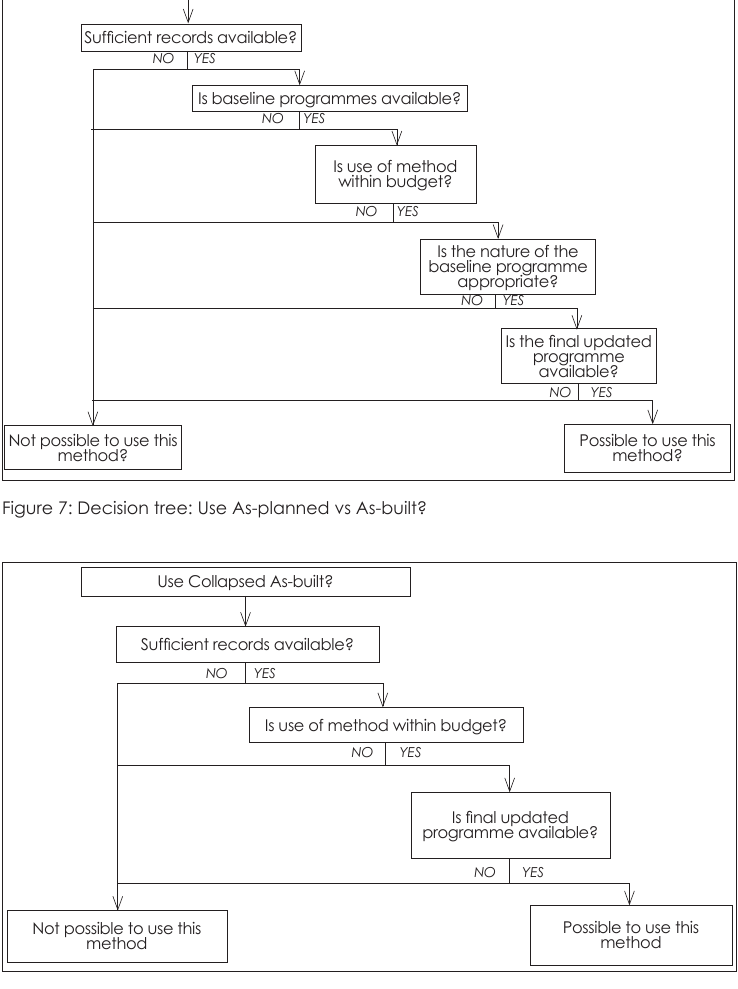
Figure 8: Decision tree: Use Collapsed